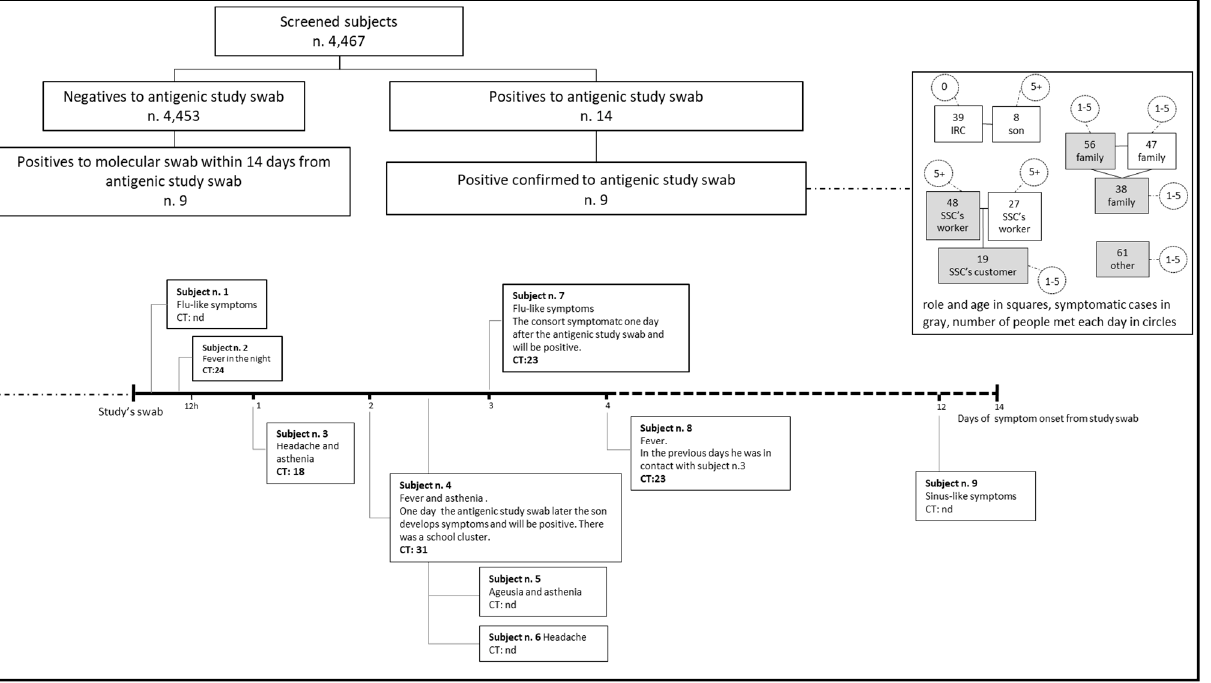
Figure 1. Analysis of individuals found positive, their symptom onset timelines and clustering of cases. Abbreviations: CT—cycle threshold; IRC—Italian Red Cross; SSC—supermarkets and shopping centers.